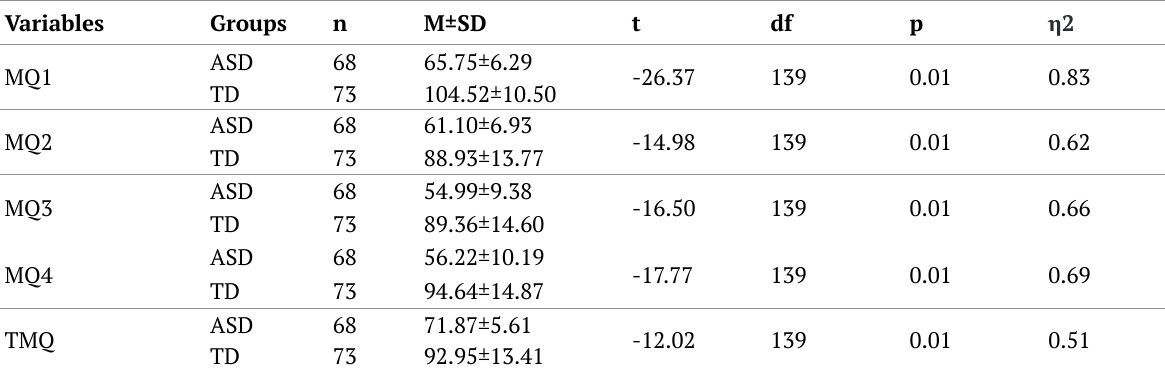
Table 2. Results of Comparing Measurement Values According to Groups (Independent Samples T-Test) Variables